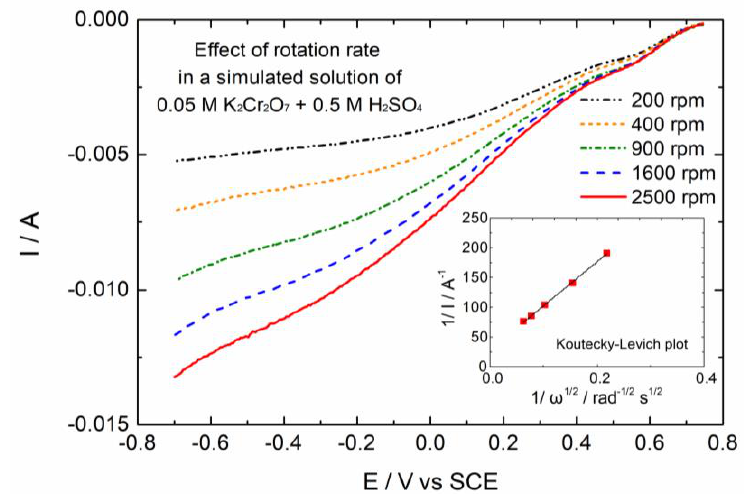
Figure 7. Current vs. potential LSV curves, recorded with GC RDE electrode at various rotation speeds (in the 200–2500 rpm range) and a 20 mV.s −1 potential scan rate, in a 0.05 M K 2 Cr 2 O 7 + 0.5 M H 2 SO 4 solution. Inset: Koyecky–Levich plot for currents at −0.6 V vs. KCl-saturated calomel reference electrode (SCE).